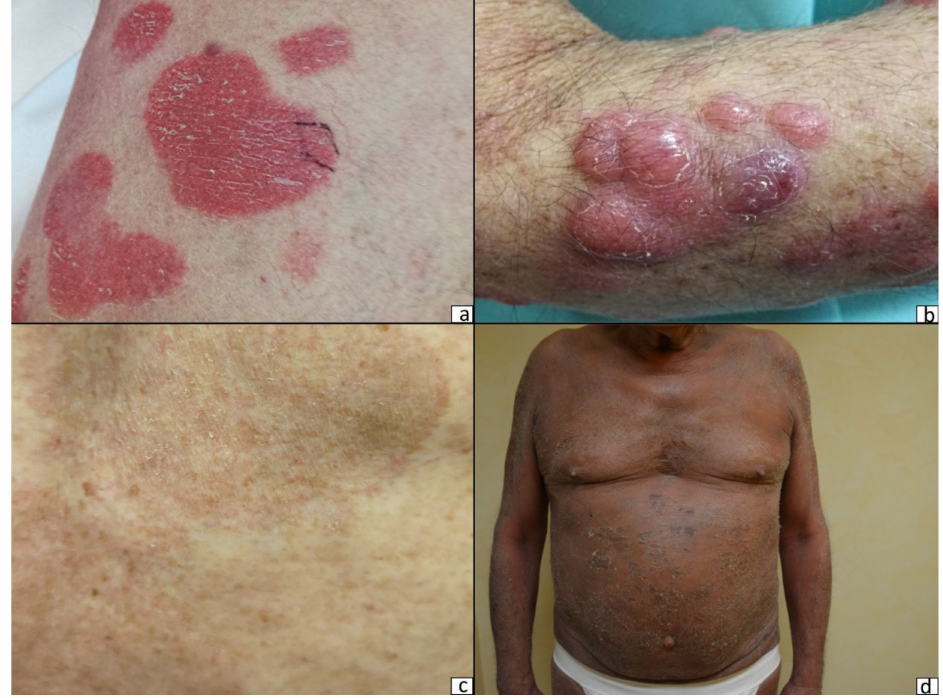
Figure 1. Different presentations of mycosis fungoides disease: ( a ) plaque stage, ( b ) tumor stage, ( c ) patch stage, and ( d ) erythroderma in a Sezary syndrome